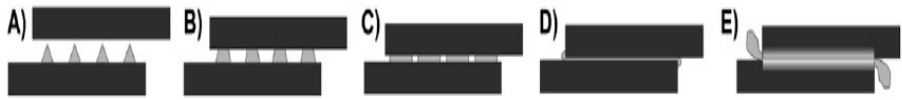
Figure 4. Power and travel curves as function of energy for the initial weld, produced with a travel of 0.5 mm. Adapted from Reference [142]. ( A ) intact EDs; ( B ) collapse of EDs due to melting; ( C ) partial flow of the EDs and melt-front arrest; ( D ) remelting of ED melt-fronts and subsequent flow out of the overlap; ( E ) complete ED squeeze out from the welding interface, with melt and partial flow of the matrix beyond the first adherend layer.